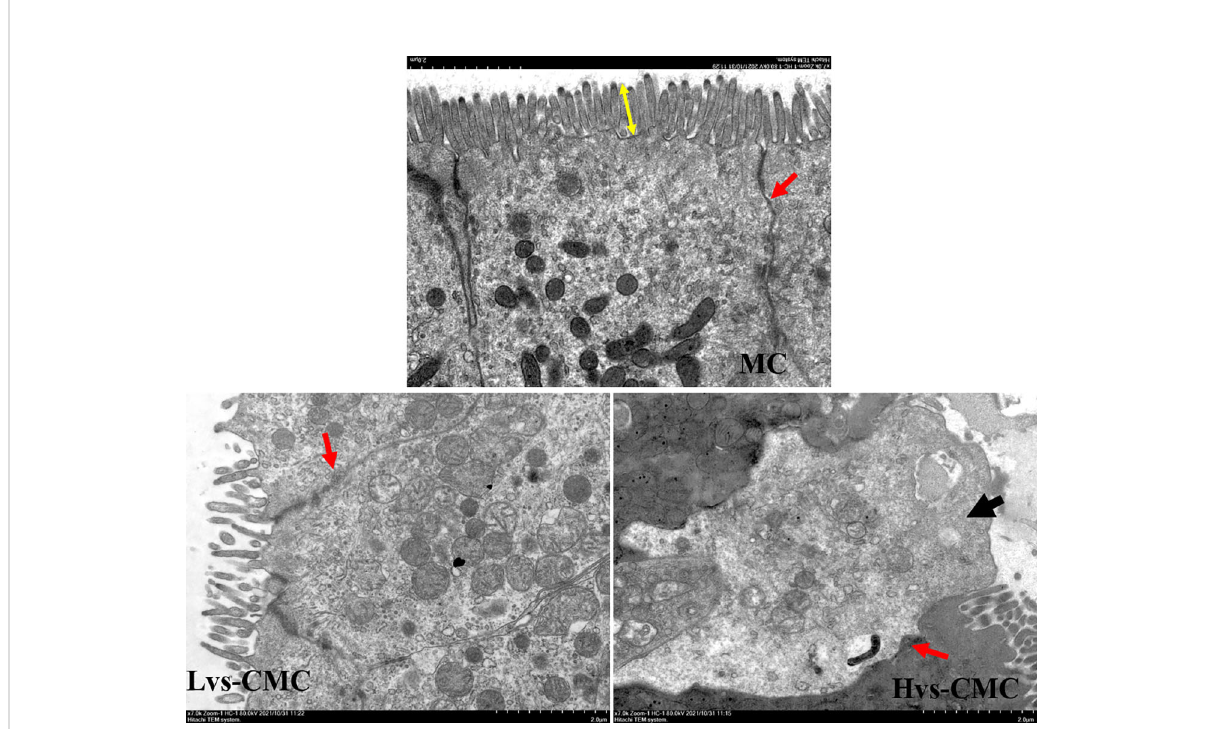
FIGURE 2 Hindgut transmission electron microscopy observation of juvenile largemouth bass fed with the test diets (magni fi cation, ×7,000). Black arrow , epithelial cell death; red arrow , epithelial cell space; yellow double-sided arrow , microvillus